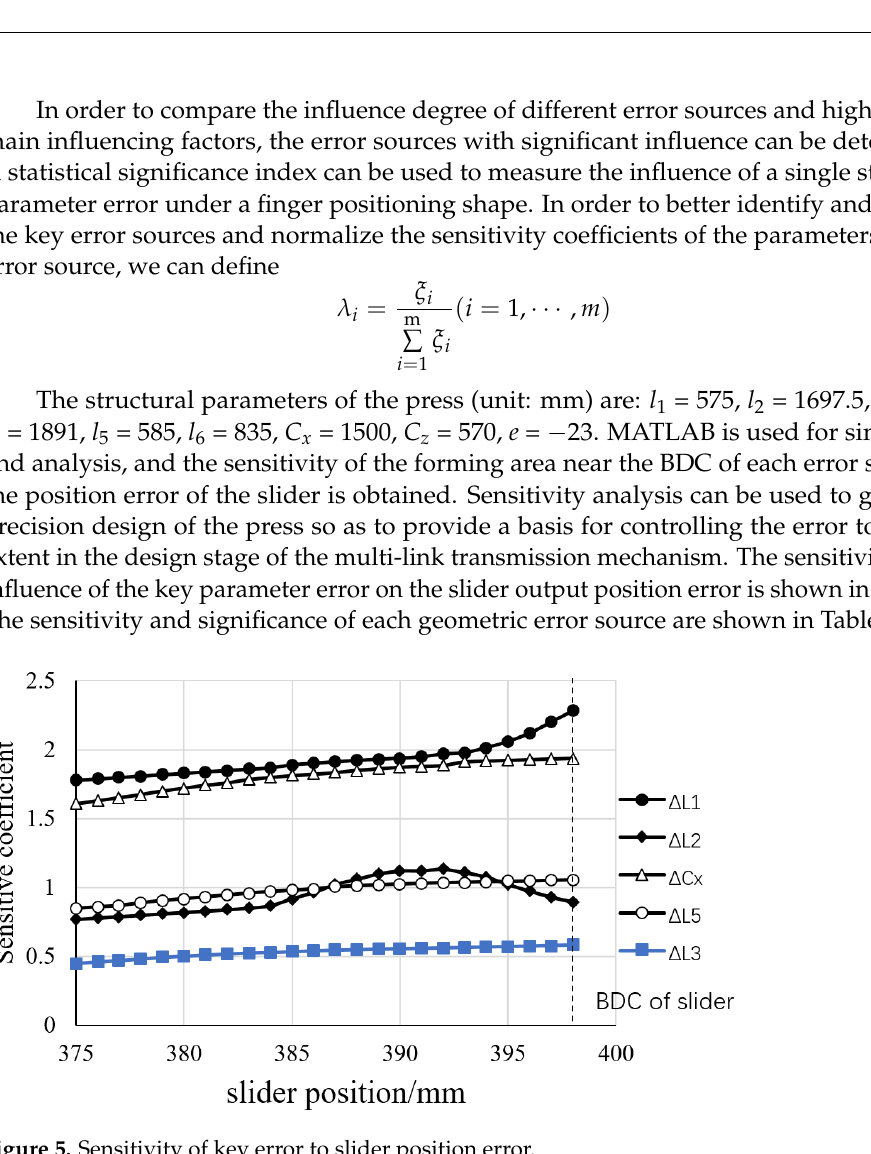
Figure 5. Sensitivity of key error to slider position error. Table 3. Main error elements and their sensitivity and significance.